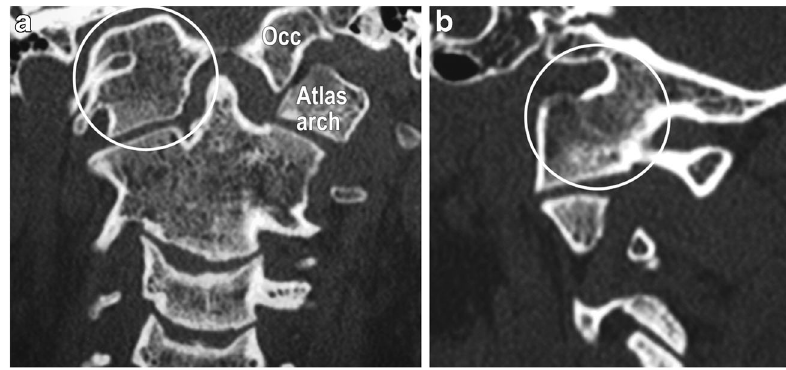
Fig. 13 Atlanto-occipital assimilation in a 19-year-old fe- male: Coronal ( a ) and sagittal ( b ) reformats from a cervical spine CT reveal abnormal fusion of the right-sided arch of atlas with the corresponding occipital condyle ( arrows ). The structures are clearly separate on the